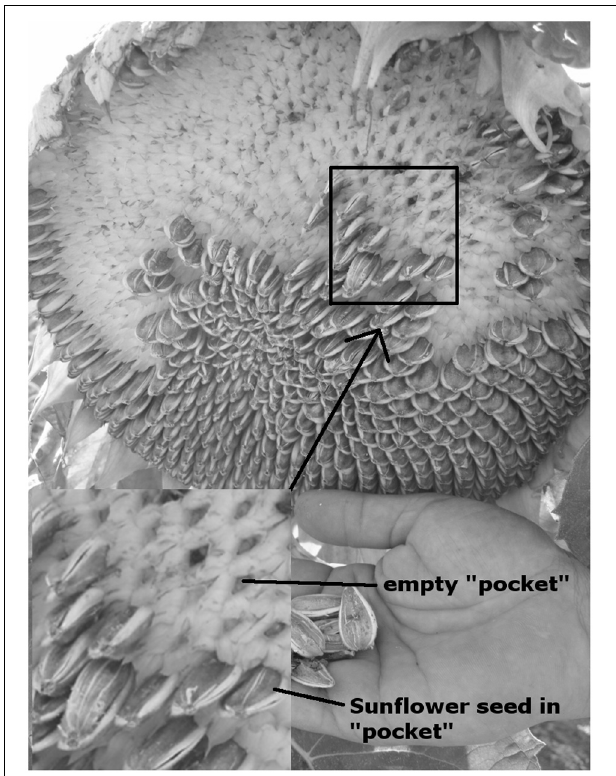
FIGURE 3 | Sunflower head with visible seed predation and empty sunflower shells from under the plant in the hand. Empty “pockets” of removed seeds and seeds in the “pockets” can be